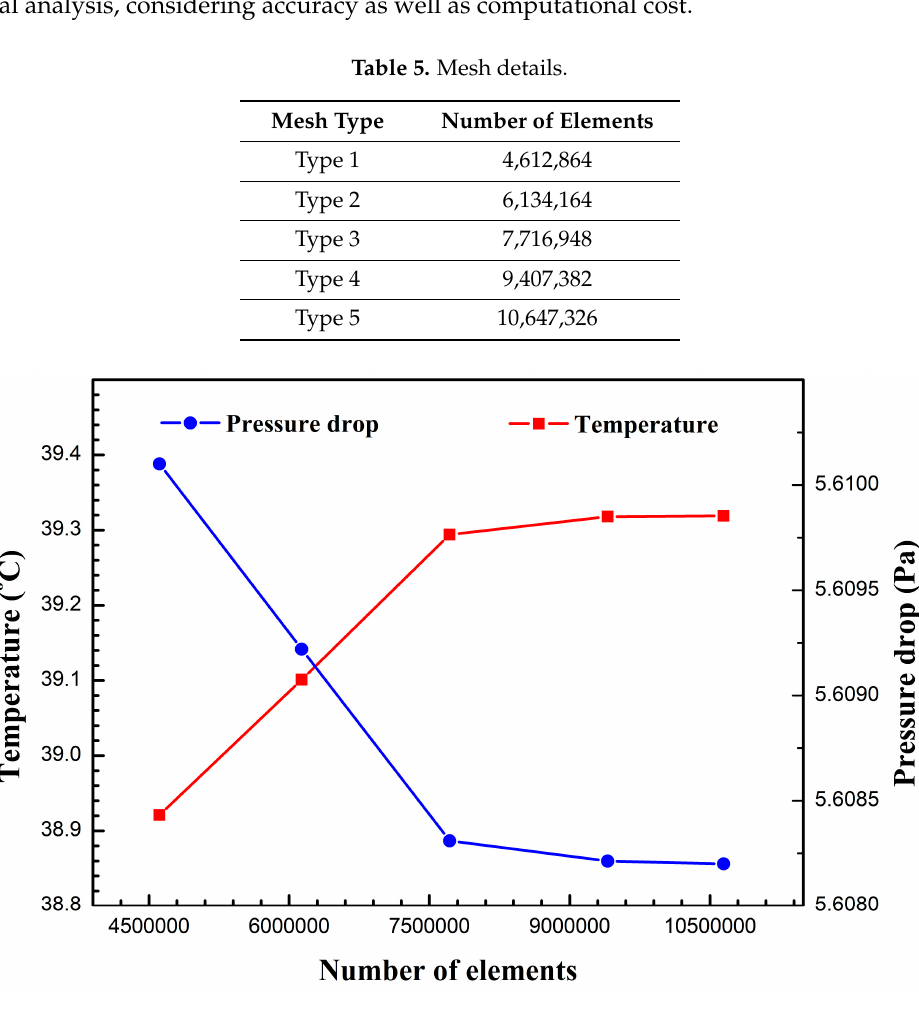
Figure 3. Mesh independency test.